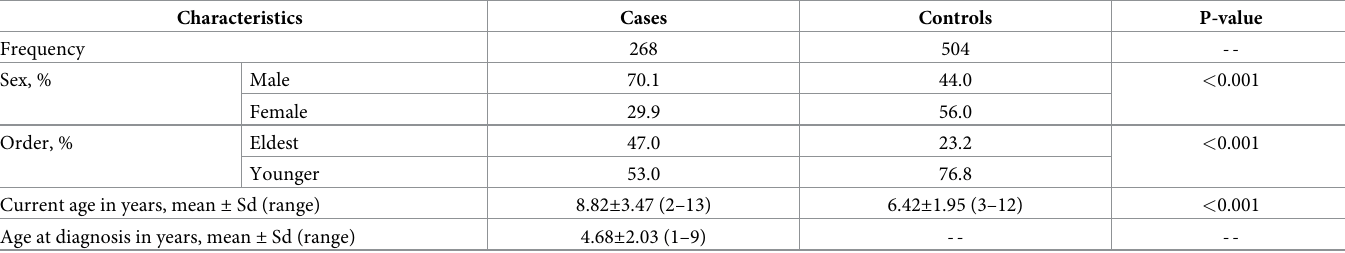
Table 1. Characteristics of